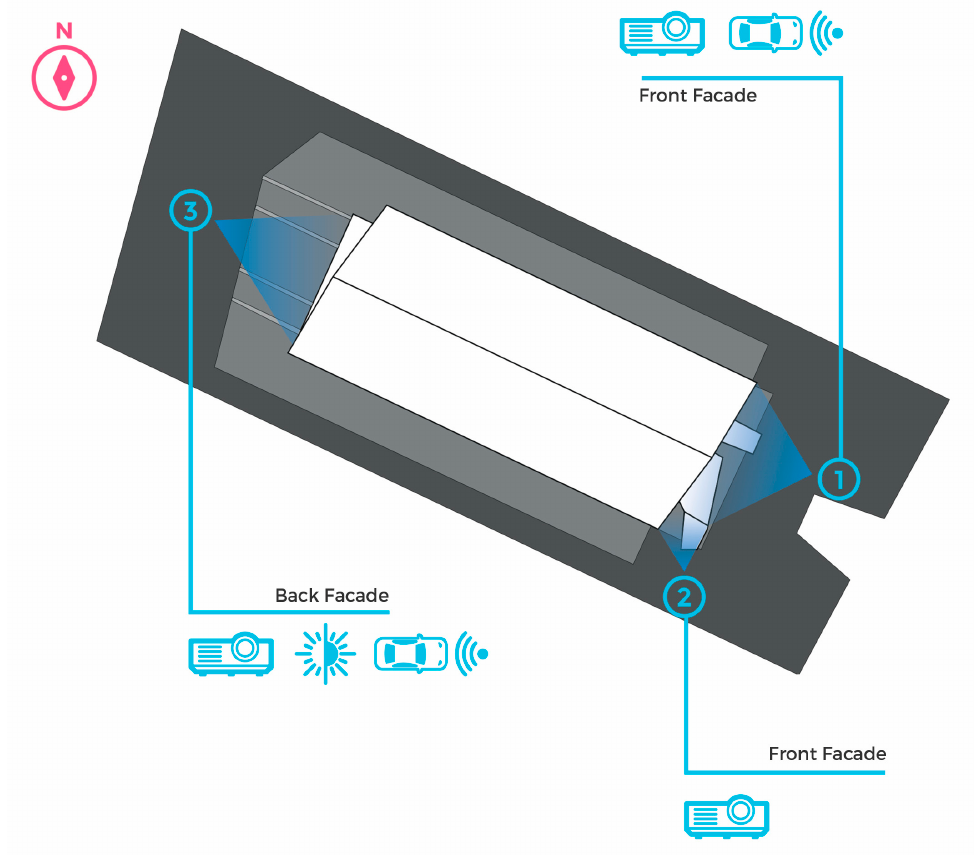
Figure 10. Project plan (image by Rosario Di Vincenzo).